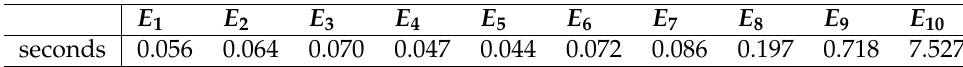
Table 9. Performances of the